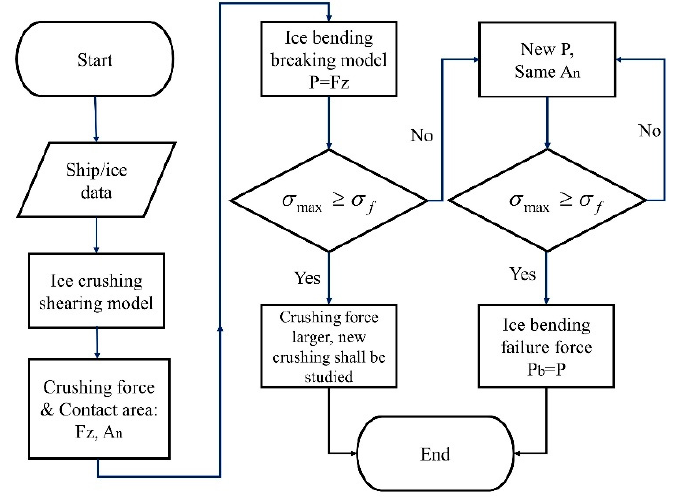
Figure 4. Description of how to obtain ice breaking force in the current model.